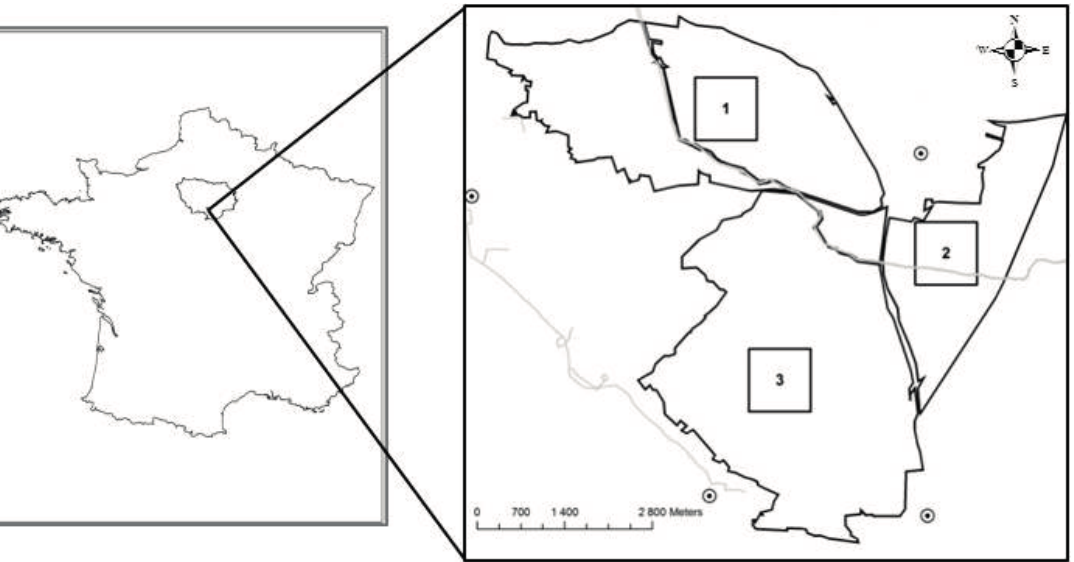
Figure 1. Location of the three study sites in the (Trois Pignons) forest: 1. Mares aux Joncs (Ma), 2. Chanfroy (Ch), and 3. Cul du Chien (Cl). The grey lines represent rivers and dark dots represent